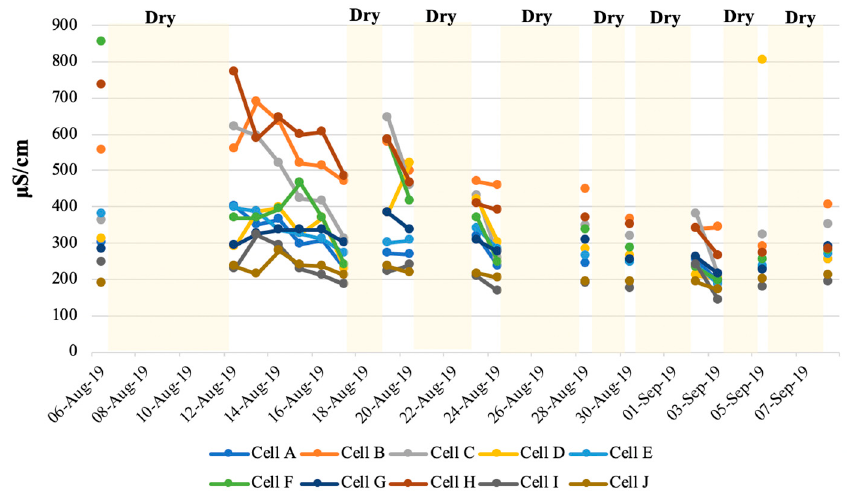
Figure 14. Variation of electroconductivity (EC) with time.